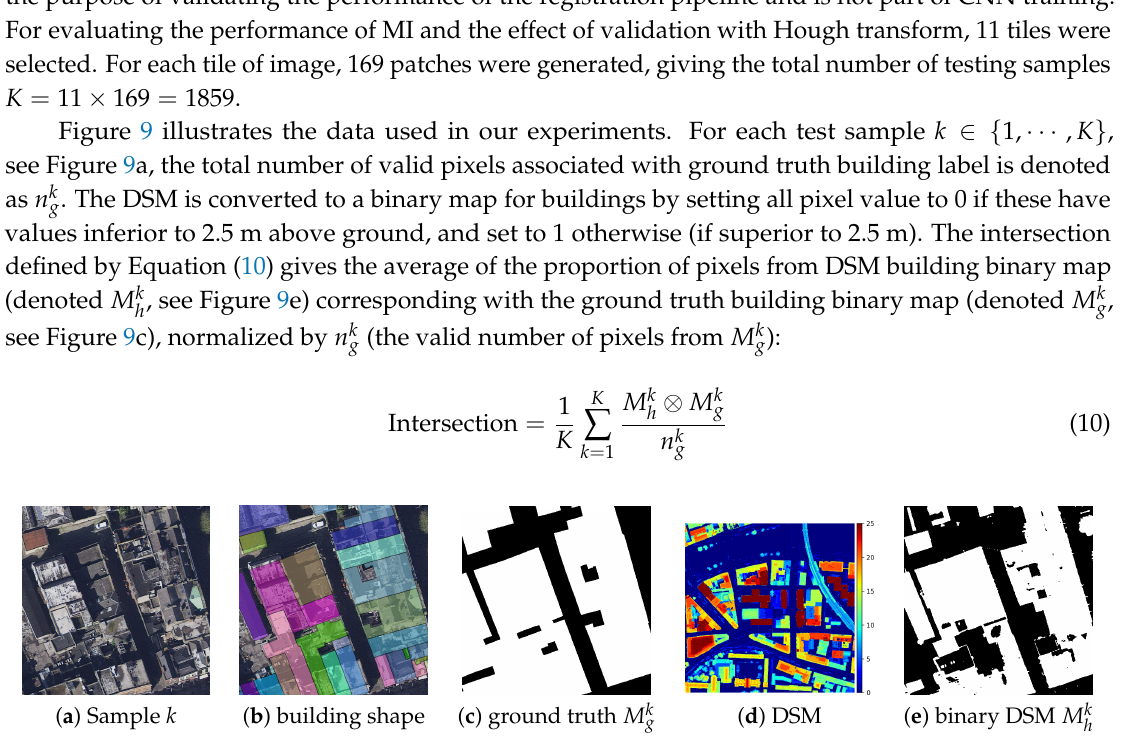
Figure 9. Example of data used for preprocessing and training.